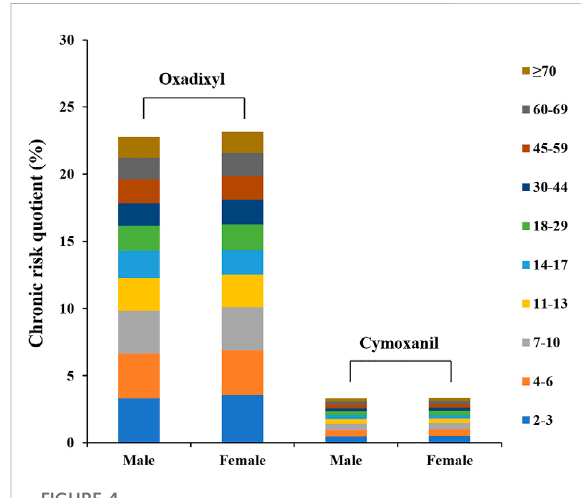
FIGURE 4 Chronic dietary risk assessment of oxadixyl and cymoxanil in